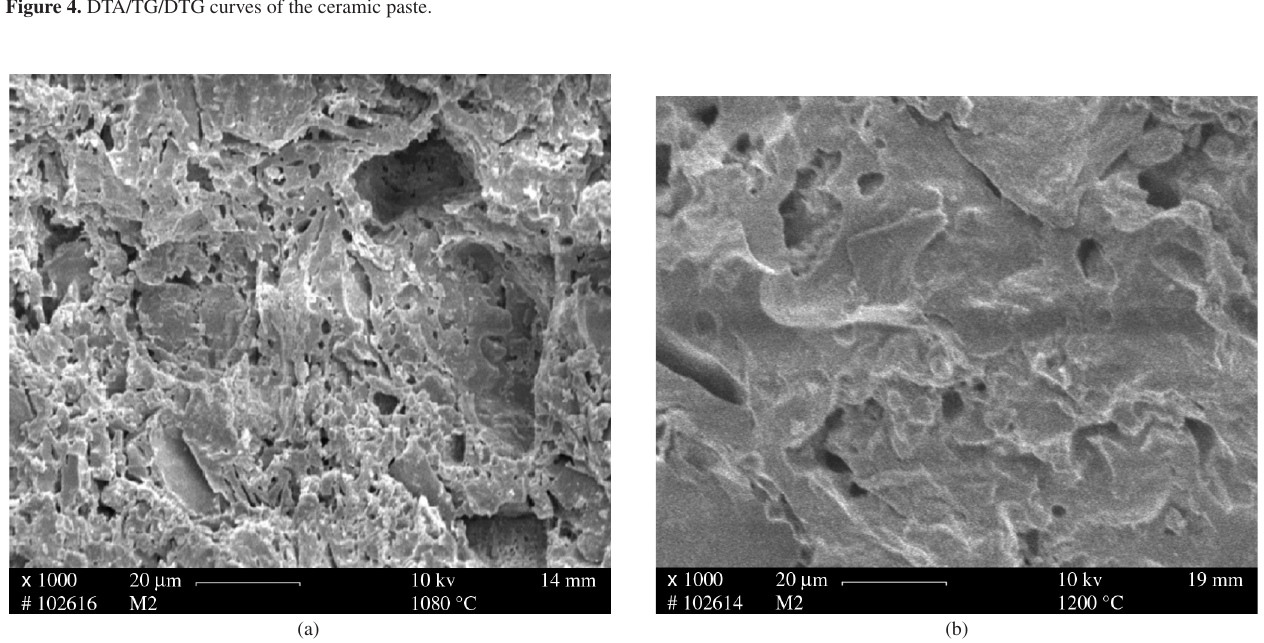
Figure 4. DTA/TG/DTG curves of the ceramic paste.